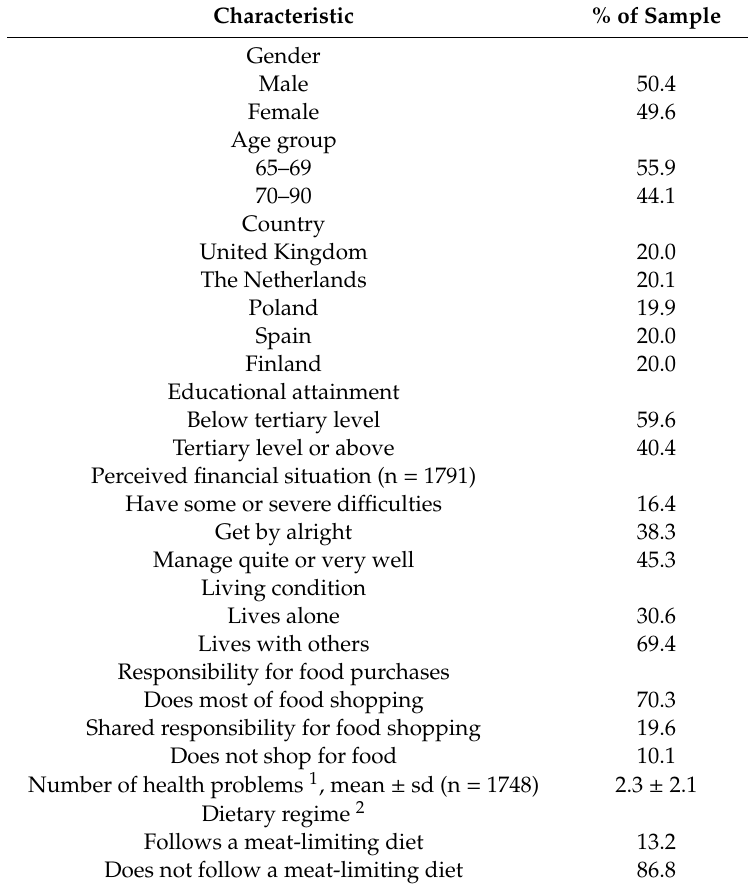
Table 1. Background characteristics of 1825 adults aged 65 years and older from five EU countries (n = 1825 unless indicated